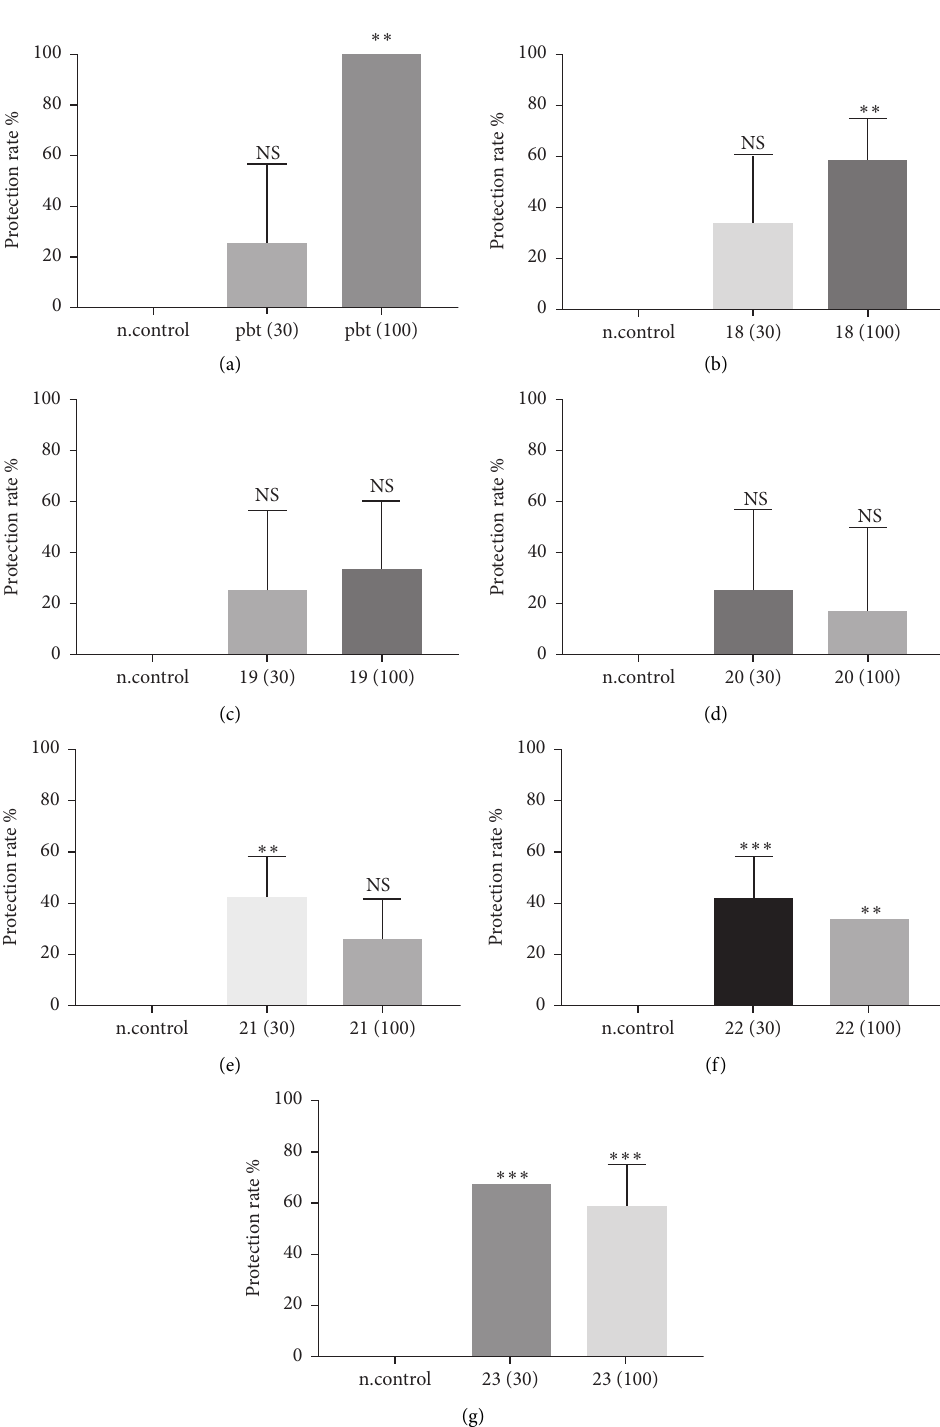
Figure 4: Protection rate of the synthesized Schiff bases (18–23) along with the standard drug phenobarbitone against PTZ-induced